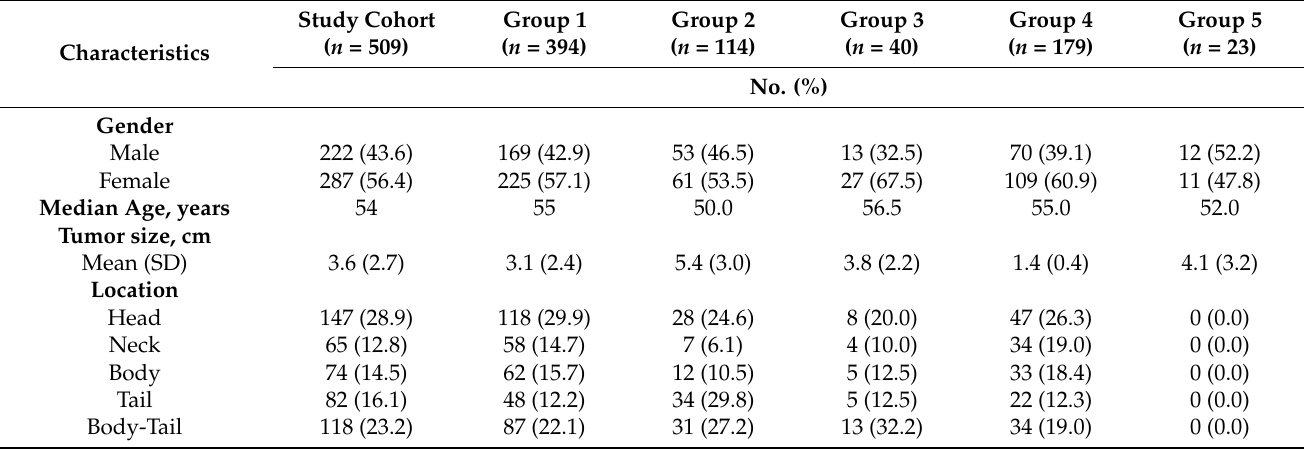
Table 1. Demographics and clinical characteristics of the NF-PanNETs cohort and each